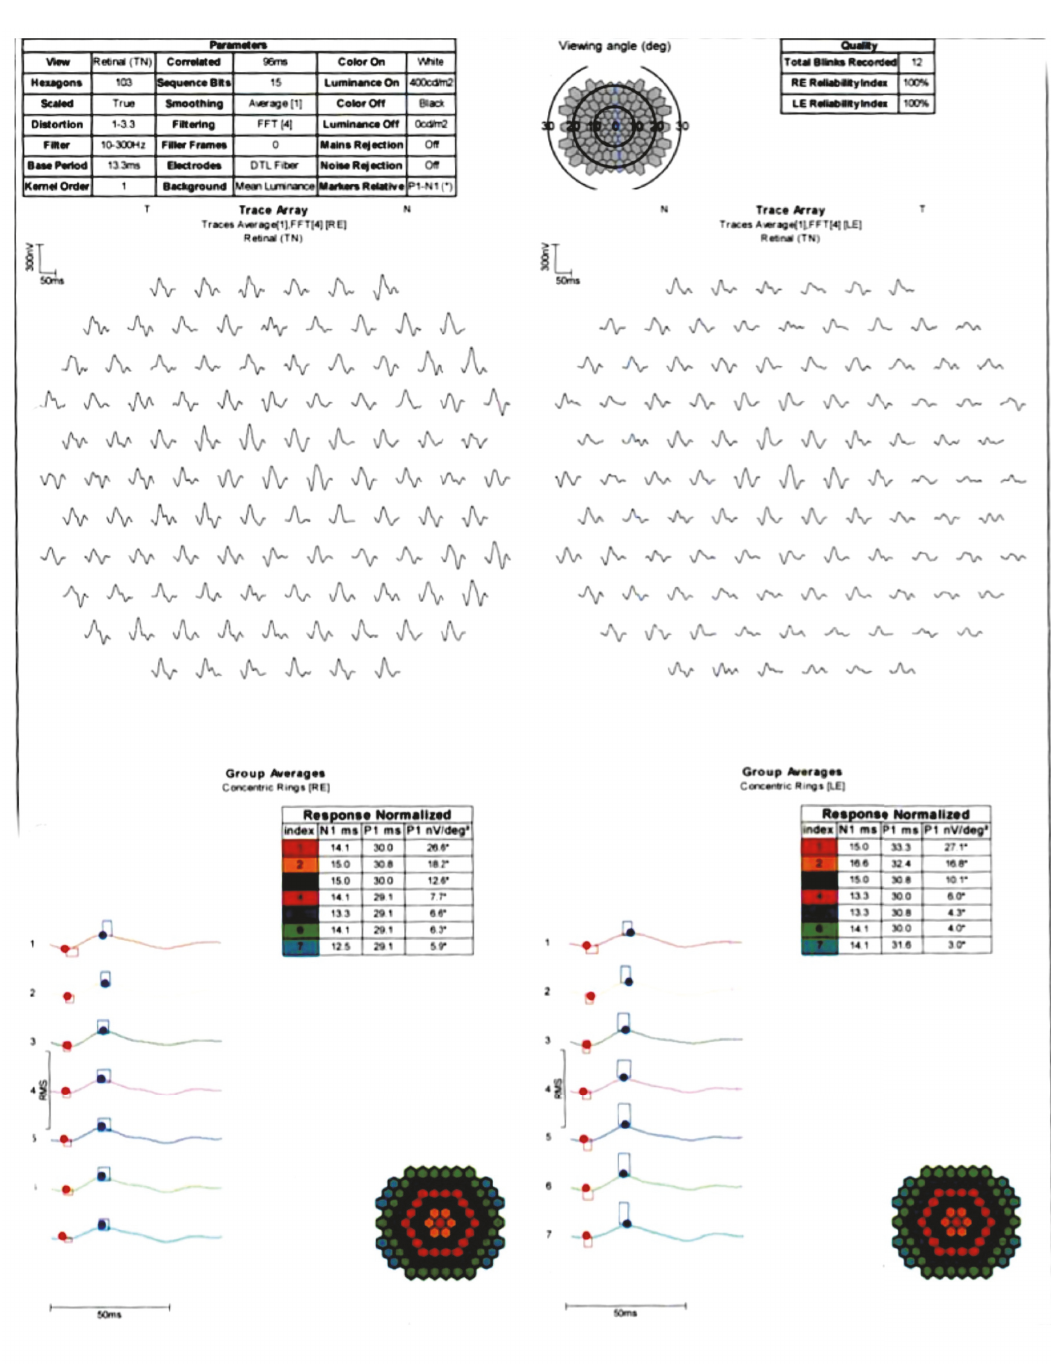
left eye. No pathologic changes were found in the right eye (Figure